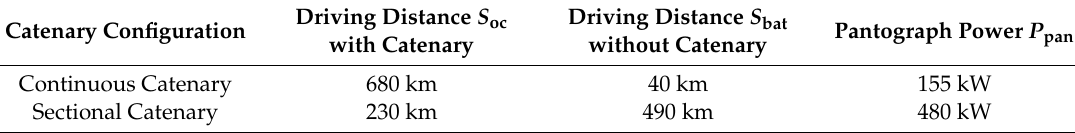
Table 3. Required pantograph power for the investigated catenary configurations.